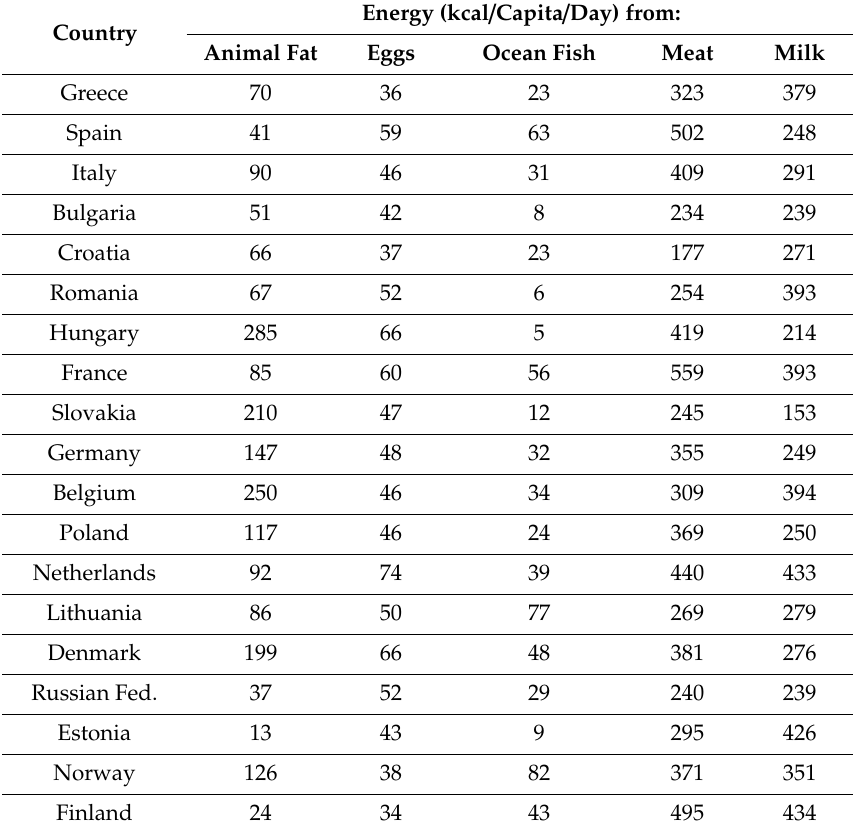
Table 3. Data on dietary energy supply for animal products in 2002 for 19 European countries from the women with osteoporosis study [22]. Energy (kcal / Capita / Day) from: Country Animal Fat Eggs Ocean Fish Meat